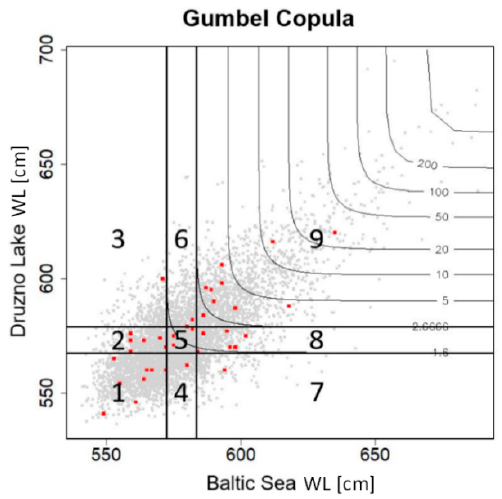
Figure 2. Example of combined accumulated curves of the probability of exceedance of maximum water levels and the determination of sectors with various degrees of synchronicity or asynchronicity of maximum water levels.